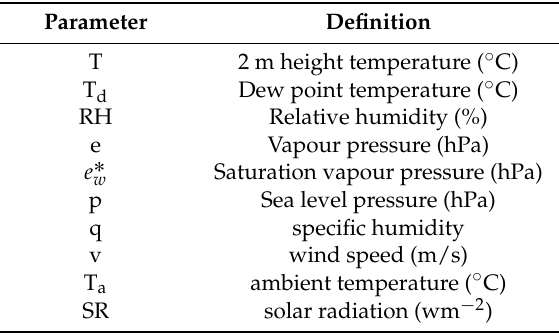
Table 4. Naming of the MERRA input variables, their definitions, and units used in the computation of the climate indices (THI, ETI, ESI, HLI, HLI new and RRP) in Table 3.